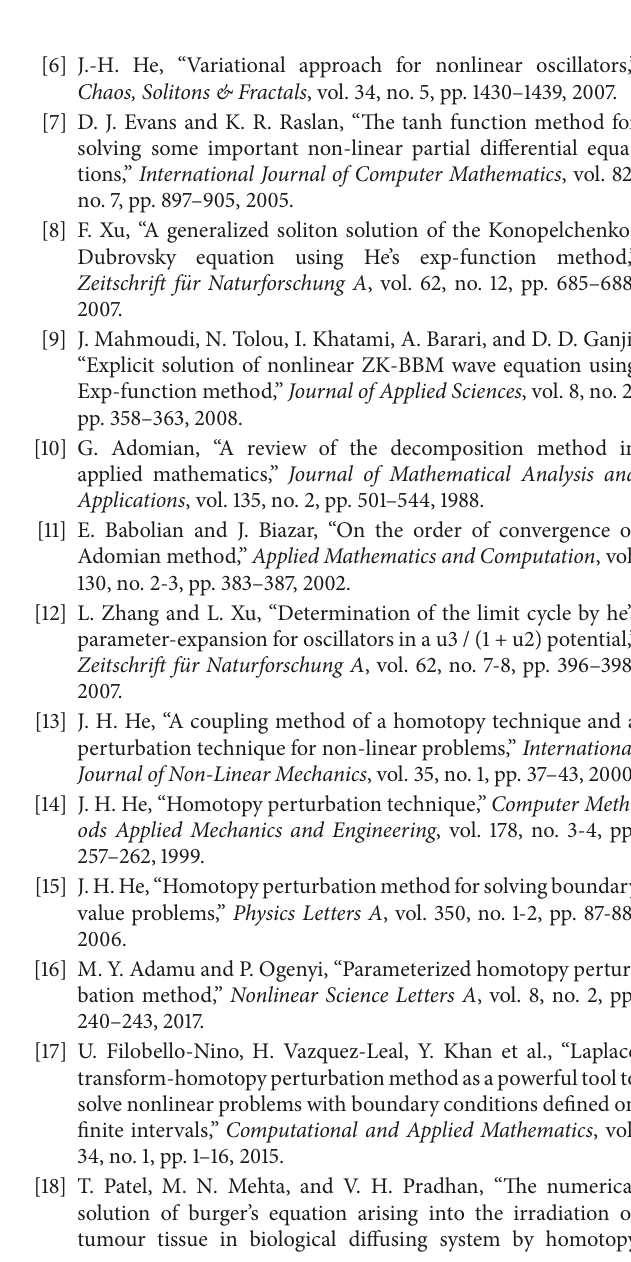
Figure 5: Absolute error for solutions